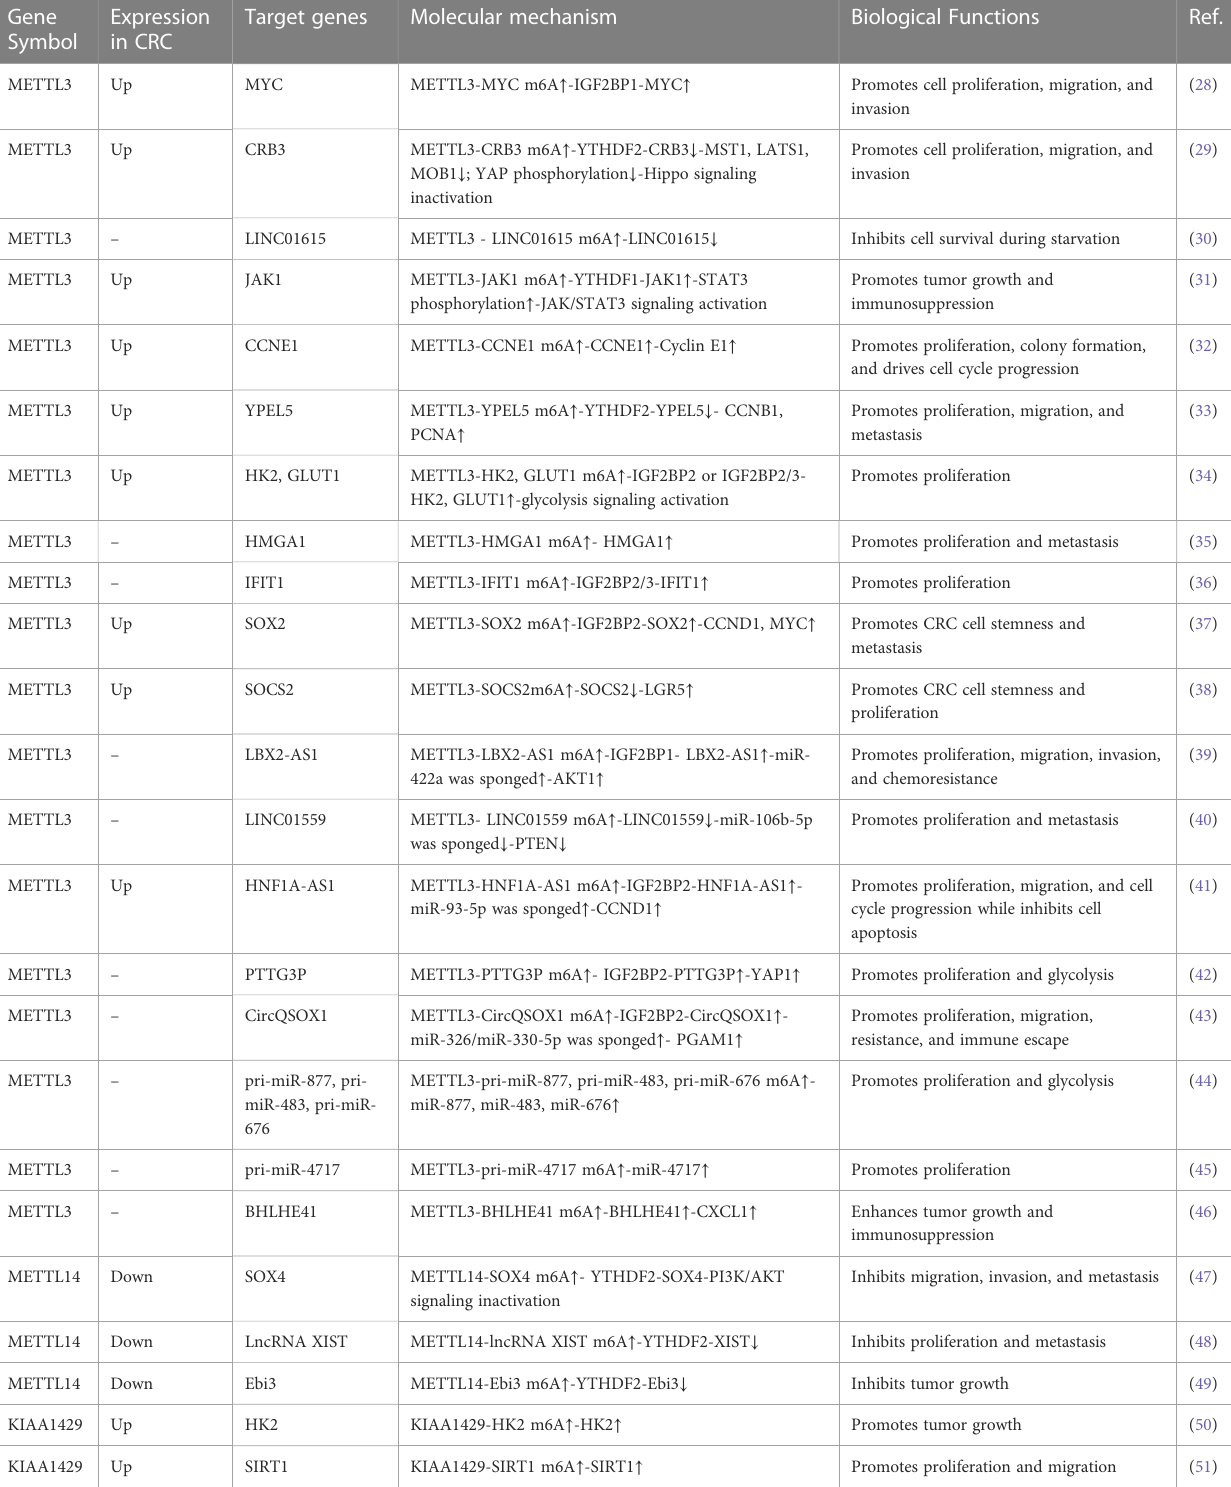
TABLE 1 Functions of m6A “ writers ” in